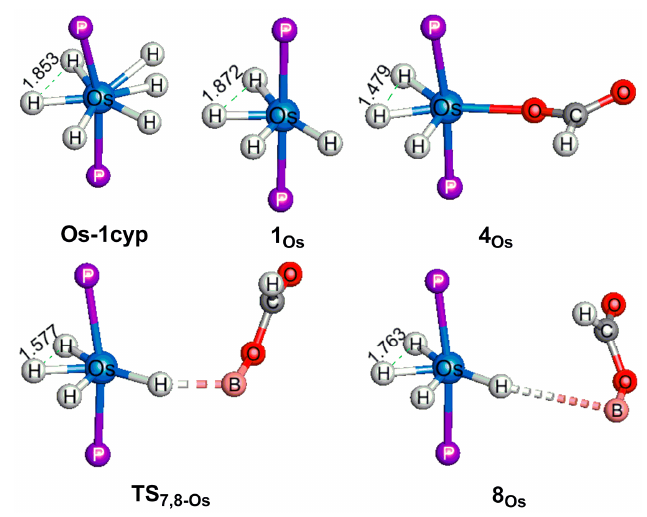
Figure 6. Optimized structures of Os ‐ 1cyp , 1 Os , 4 Os , TS 7,8 ‐ Os (239 i cm − 1 ) and 8 Os . Bond lengths are in Å. The cyclopentyl and pinacol groups are not shown for clarity.